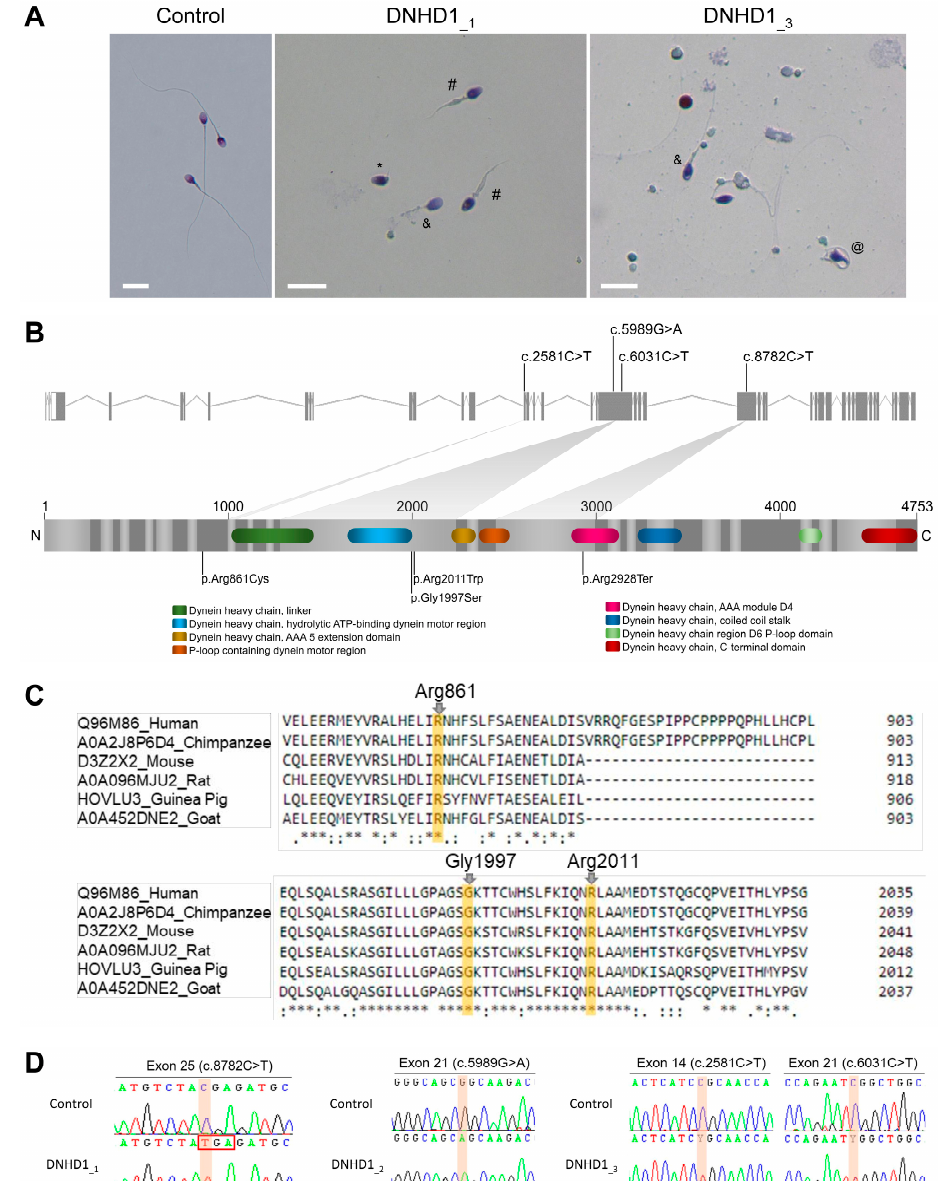
Figure 1. Sperm morphology and description of the identified DNHD1 variants. ( A ) Light microscopy analysis of spermatozoa from fertile control individual, patient DNHD1 _1 and patient DNHD1 _3 . Most spermatozoa from DNHD1 patients have flagella that are short (#), absent (*), coiled (@) or of irregular caliber (&). Head malformations were also observed. Scale bar = 10 µ m. ( B ) DNHD1 gene structure (ENST00000254579.11) showing the location of the variants described. The functional structure of the encoded protein is shown in the lower panel. Colored boxes on the protein represent functional domains according to UniProtKB (Q96M86) and the DECIPHER database. ( C ) Conservation and alignment of DNHD1 sequences from several orthologs around the missense mutated amino acids reported in the present study (marked by a yellow square). ( D ) Electropherograms obtained by Sanger sequencing showing the homozygous mutations c.8782C>T and c.5989G>A identified in the patients DNHD1 _1 and DNHD1 _2 , respectively, and the two heterozygous variants (c.2581C>T and c.6031C>T) of DNHD1 identified in subject DNHD1 _3 . The patient DNHD1 _1 carried a stop-gain variant c.8782C>T; p.(Arg2928Ter) (NM_144666.3) located in the exon 25 (Figure 1B). The variant is present in the Genome Aggregation Database (gnomAD v2.1, http://gnomad.broadinstitute.org/, accessed